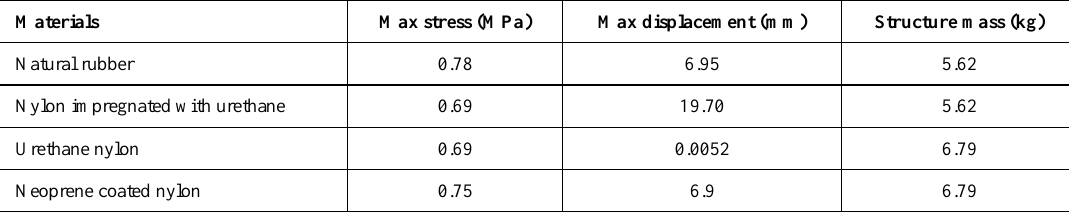
Table 2. Structural analysis results for various skirt